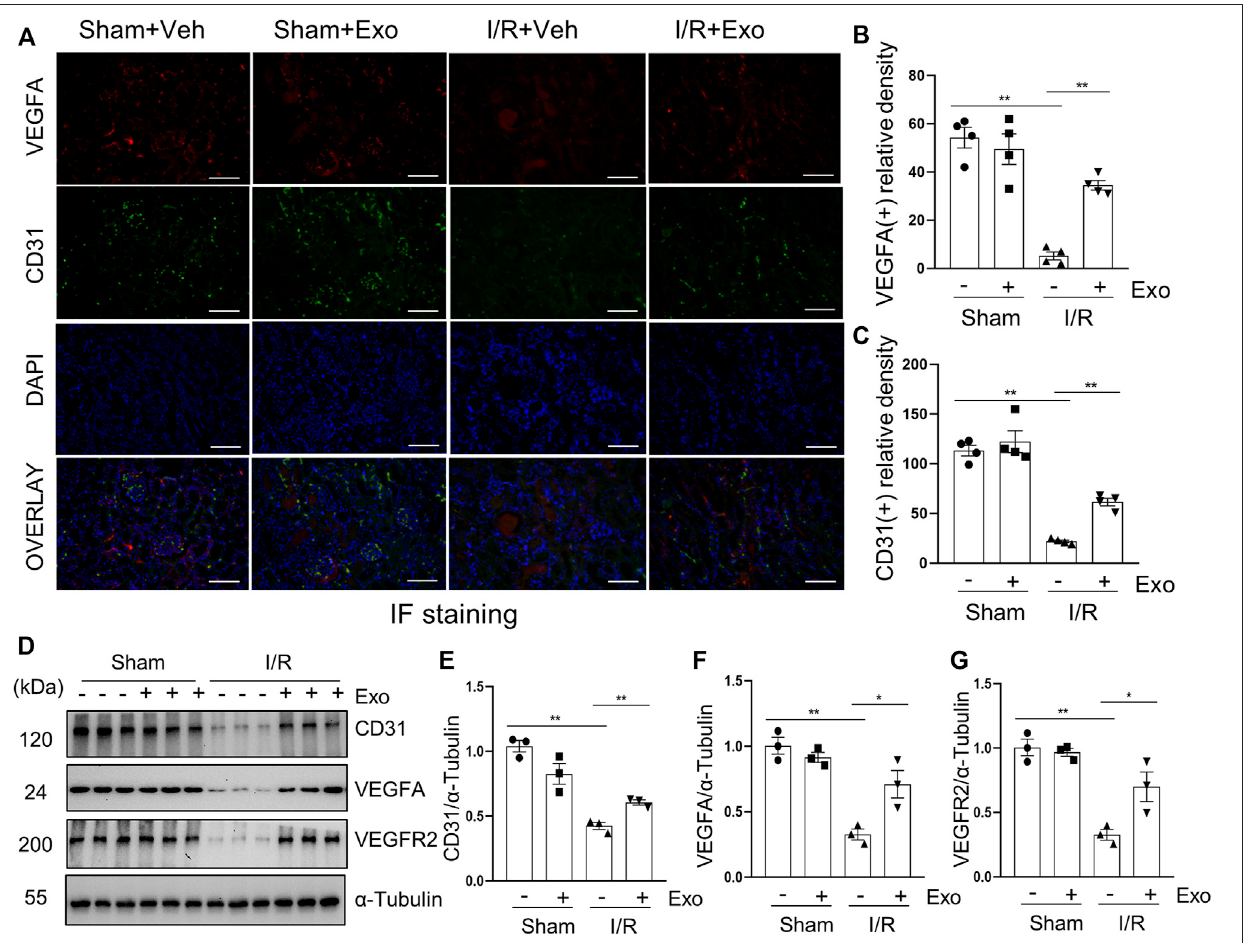
FIGURE8| MSCs-derivedexosomesrestorelossofrenalangiogenesis. (A) Photomicrographsillustratingco-immuno fl uorescencestainingofendothelialmarkers CD31and VEGFA.Scalebar =200 µm.Quanti fi cation and plotofimmuno fl uorescence density ofVEGFA (B) and CD31 (C) . (D) Porcinekidneytissuelysates fromeach group were subject to immunoblot analysis with speci fi c antibodies against CD31, VEGFA and VEGFR2. Expression levels of CD31 (E) , VEGFA (F) and VEGFR2 (G) , were quanti fi ed by densitometry analysis and then normalized with α -Tubulin. Data are means ± sem.* p < 0.05; ** p < 0.01 versus sham controls.